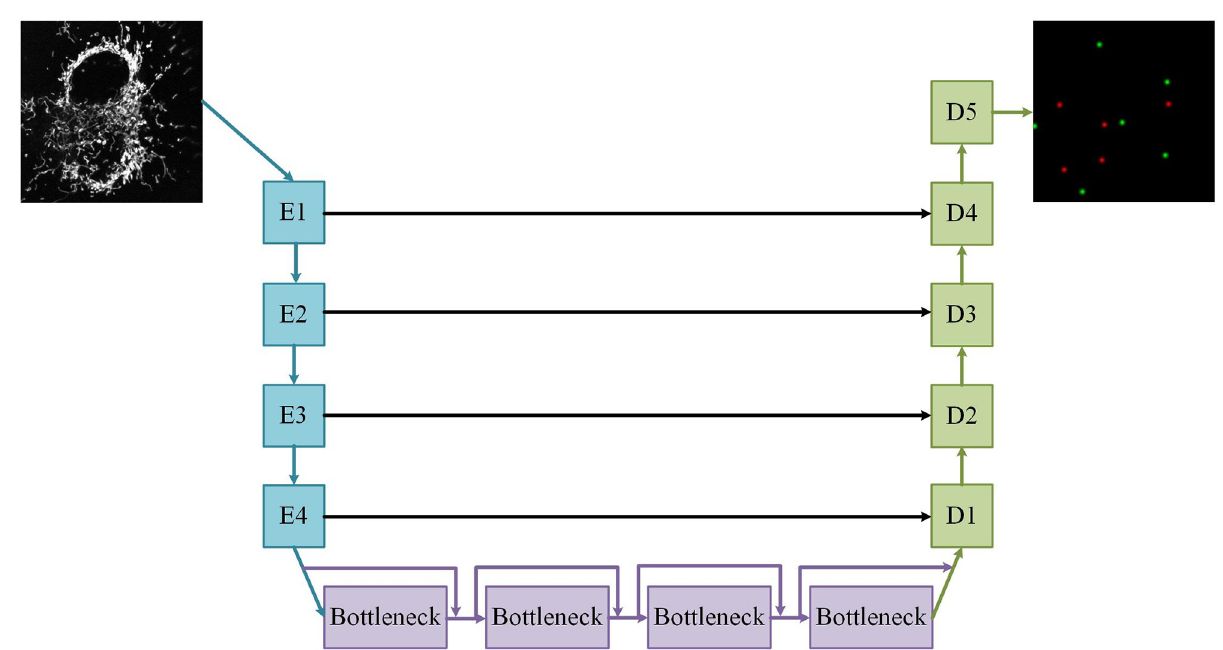
Fig 7. The Vox2Vox GAN generator architecture. The generator is constructed from four encoder blocks ( E ) and five decoder blocks ( D ), connected with four bottle-neck blocks. The black arrows represent the skip connections and the purple arrows the short Res-Net style short skip connections. A single input frame is used to predict the locations of mitochondrial fission, fusion and depolarisation events on a black background.